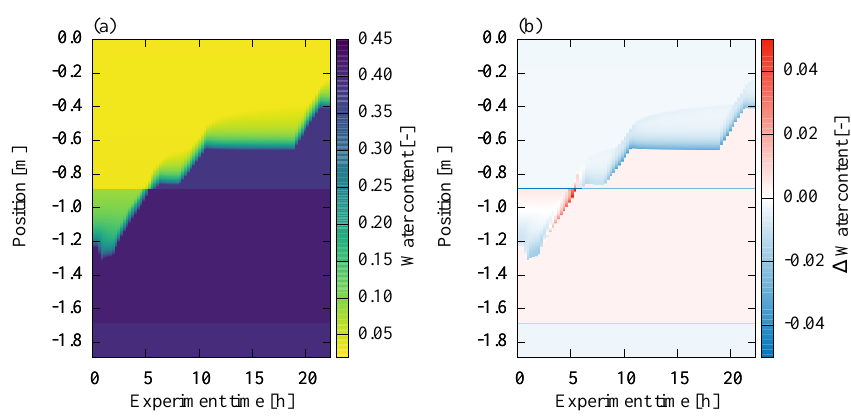
Figure 12. This figure shows (a) the water content distribution simulated with the resulting mean parameter set and (b) the difference to the true water content distribution (Fig. 9). The mean absolute deviation of the volumetric water content is 0 . 004. The overall balance of the volumetric water content can be characterized by calculating the mean of the summed difference per grid cell over all measurement times which yields − 0 . 003. Hence, the mean parameter set generally underestimates the water content in the profile. The constant deviations above as well as below the groundwater table and in the gravel layer are due to small deviations in the estimated parameters θ C r , θ C s , θ A s , and θ G s . Still, the standard deviation of the estimated parameters contains the true parameter values (Table